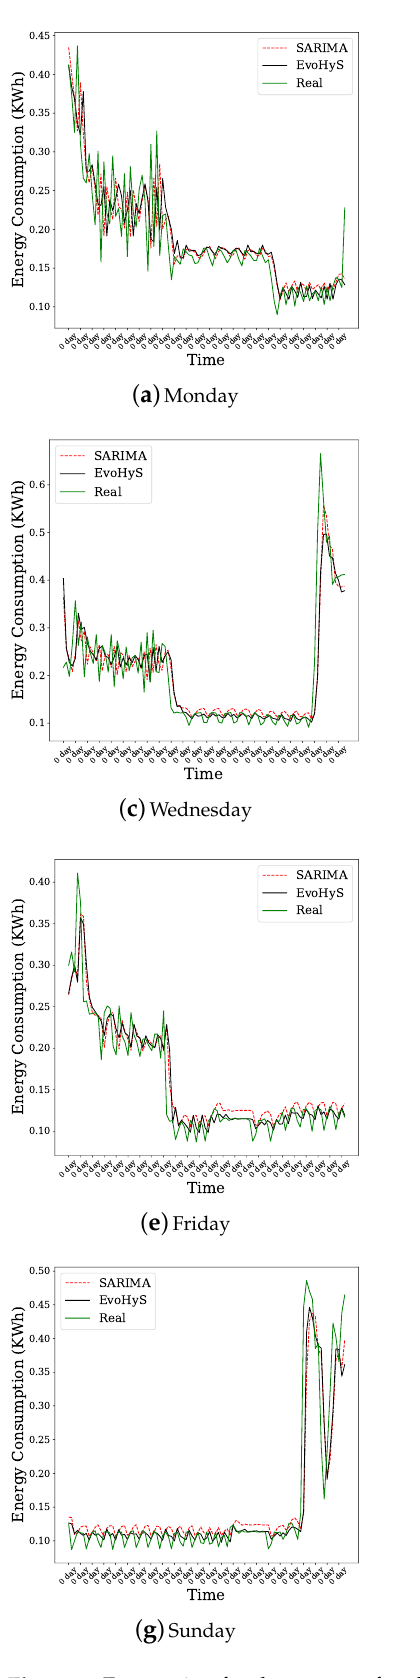
Figure 4. Forecasting for the test set of each day of the week with Seasonal Autoregressive Integrated Moving Average (SARIMA) and